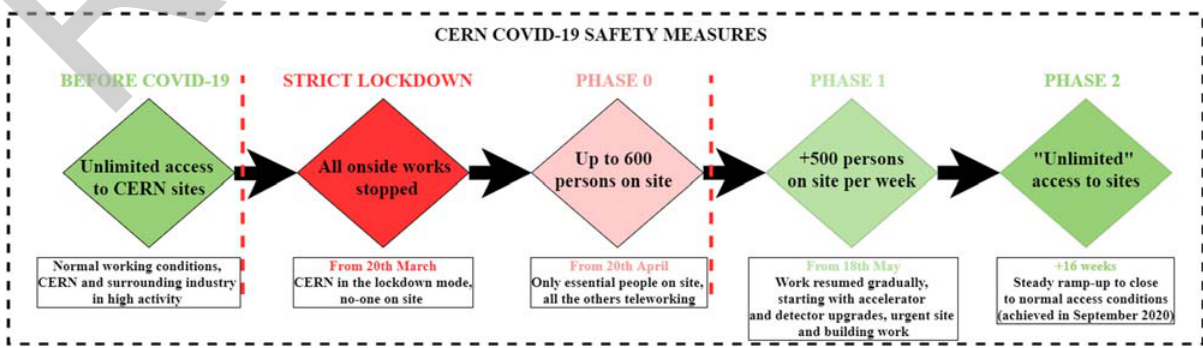
Figure 3: Phases of limitation of users ’ access to CERN